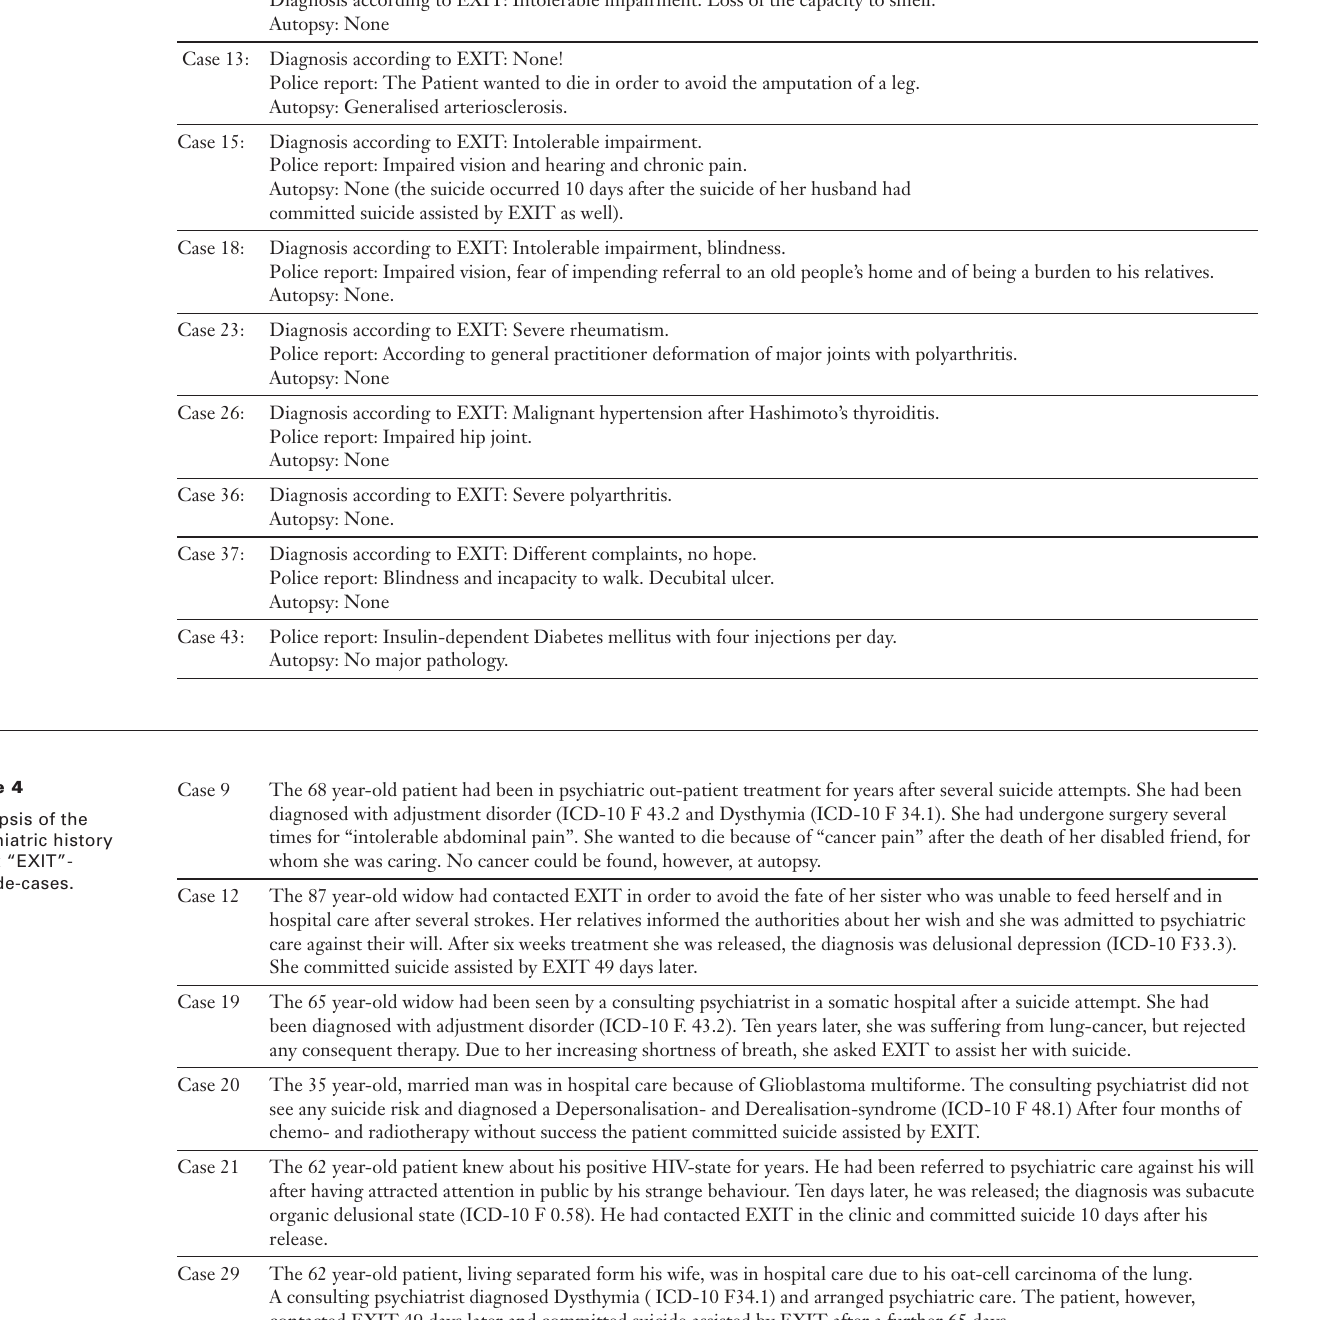
“EXIT“-suicides with no apparent disabling or terminal illness.